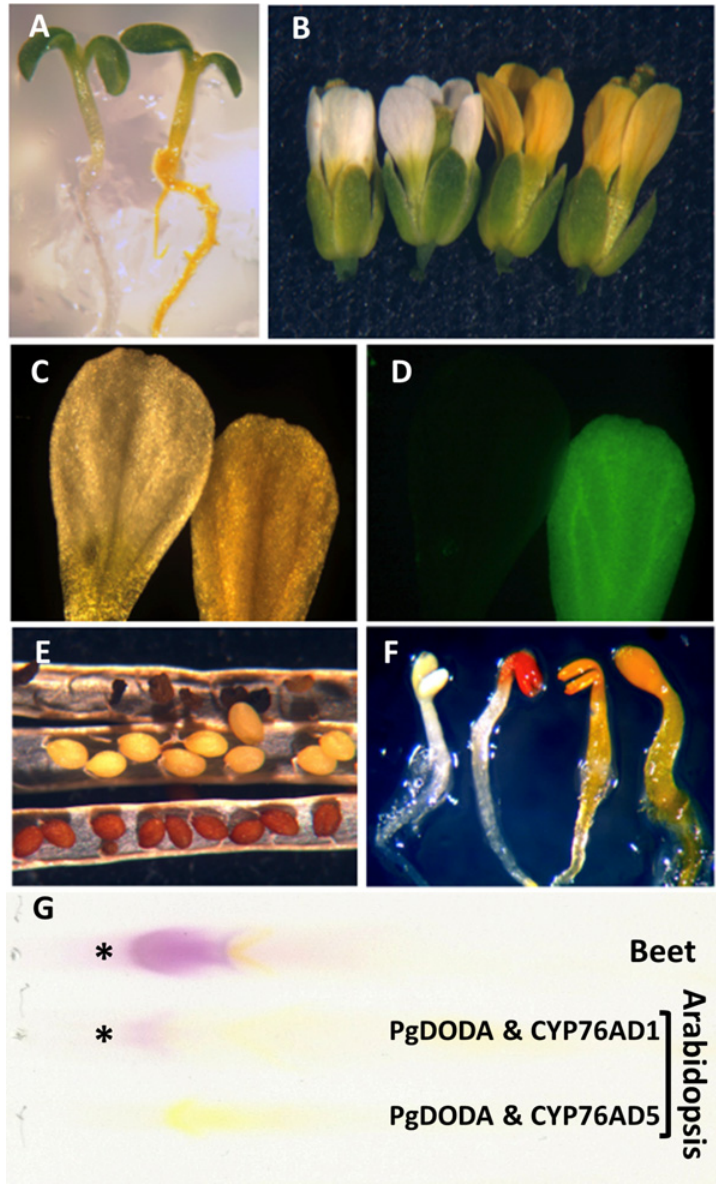
Fig 4. Arabidopsis expressing betalain biosynthetic genes produce visible pigment phenotypes. All Arabidopsis are ttg1-1 mutant except the wild type L er ecotype in panel E. A. left, 35S : CYP76AD5 alone, right 35S : CYP76AD5 and 35S : PgDODA . B. left two flowers and right two flowers the same as in A. C and D are images of the same two petals. Left and right, the same as in A and B. C. white light, D. excitation with UV irradiation showing fluorescence of betaxanthins. E. mature siliques with seeds; top- 35S : CYP76AD5 in ttg1-1 alone, middle- 35S : PgDODA in ttg1-1 alone, bottom-wild type L er , no transgene. F. seedlings, left to right- 35S : CYP76AD1 and 35S : PgDODA unfed; 35S : CYP76AD1 and 35S : PgDODA fed 1.5 mM tyrosine; 35S : CYP76AD5 and 35S : PgDODA fed 1.5 mM tyrosine; 35S : CYP76AD5 and 35S : PgDODA unfed. G. Thin Layer Chromatography of betalain pigments: top-untransformed red beet; middle-Arabidopsis transformed with 35S : CYP76AD1 and 35S : PgDODA fed 1.5 mM tyrosine; bottom-Arabidopsis transformed with 35S : CYP76AD5 and 35S : PgDODA fed 1.5 mM tyrosine. Asterisks mark the presence of red betacyanins.